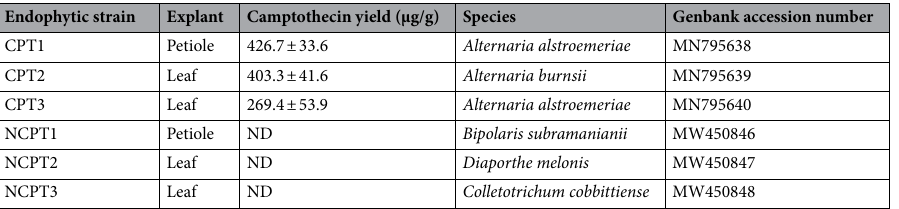
Table 1. Endophytic strains yielding CPT and their non-CPT yielding pair isolated from the same explant. # ND not